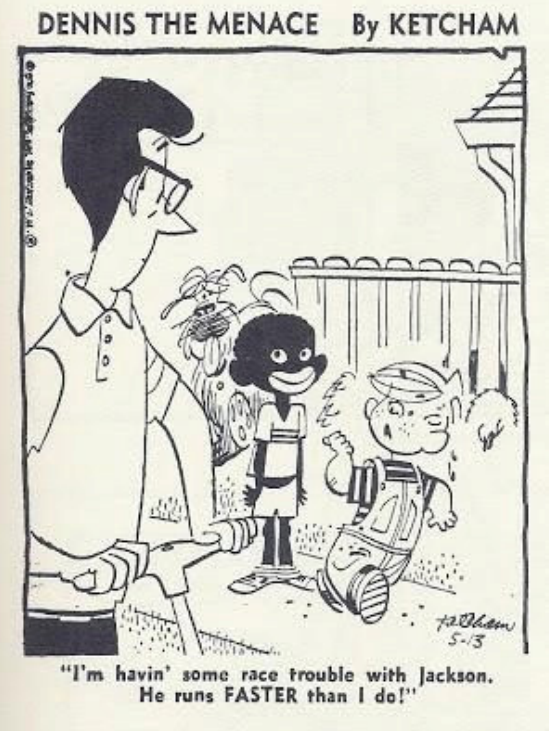
Figure 3. Hank Ketcham (1970) Dennis the Menace . Copyright permission obtained from Fantagraphics. Not coincidentally, the pain and suffering of Black adults and Black children is reflected in the actual games white people played at the expense of Black folks. In these games, both Black children and Black adults were targets of objects tossed and thrown aggressively